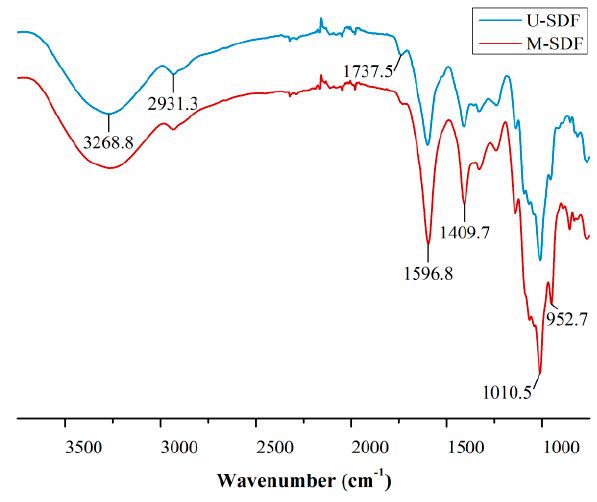
Figure 4. FT-IR spectra of the U-SDF and M-SDF.